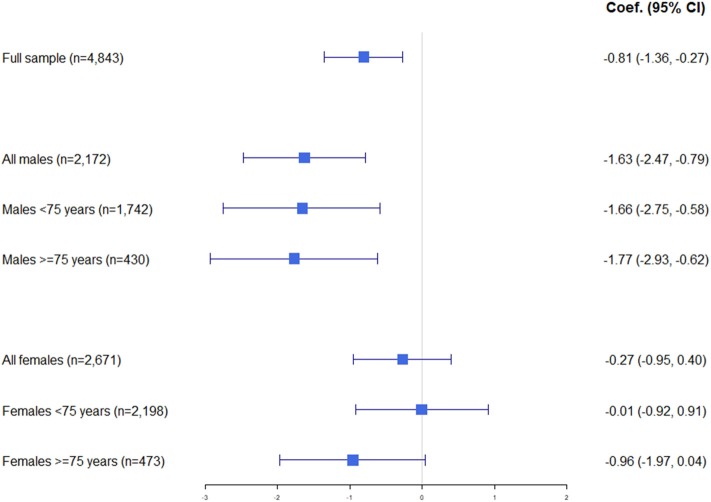
Graphical summary of results of weighted linear regression Model 3 with coefficient and 95% confidence intervals.